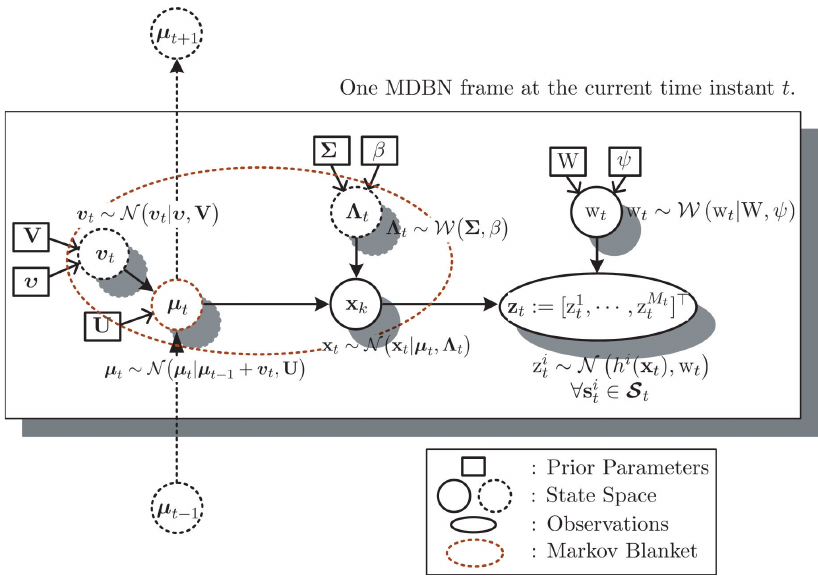
Figure 2. A general multi-layer dynamic Bayesian network (MDBN) model for the online tracking problem. This graph presents a temporal Bayesian network at the current time instant t . Here, the dotted circles denote the hidden variables, which cannot be directly observed, while the solid circle denotes the variables that can be measured. These variables together formulate the state space of